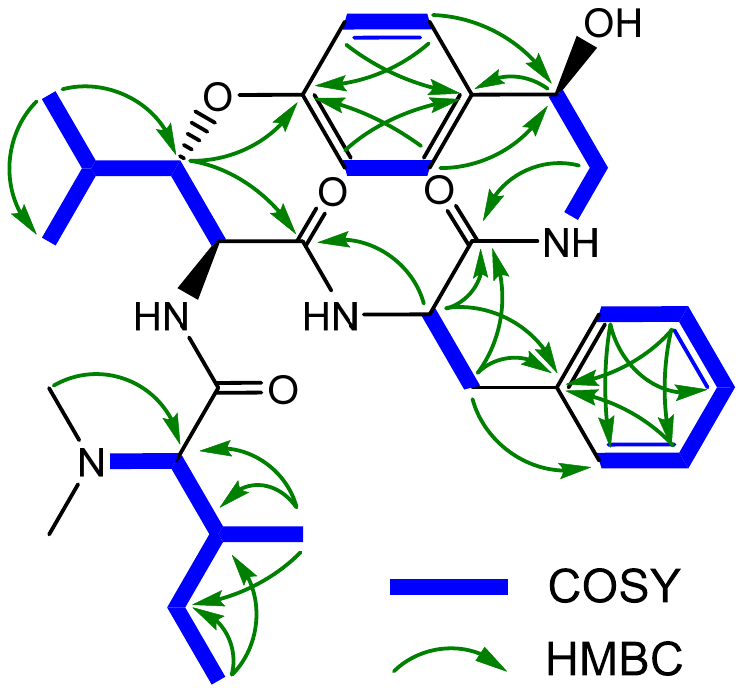
Figure 3. Key 2D NMR correlations of pandamine ( 1 ). Particular attention has been paid to the signals associated with the stereochemically- undefined β -hydroxyleucine residue. The magnitude of the vicinal coupling constants re- lated to the β -methine of the oxyleucine residue H-9 ( δ H 4.69, dd, J = 9.0, 1.8 Hz) were strongly reminiscent of those observed in 14-membered ansapeptides featuring an erythro- β -hydroxyleucine, hinting that pandamine should include a similar relative con- figuration for this residue [34] (a threo configuration would be expected to result in a J 8,9 coupling of about 2 Hz) [35]. Likewise, the cursory analysis of the 13 C NMR chemical shifts related to the α and β -methines for the L -erythro and D -erythro β -OH amino acids incor- porated in 14-membered para ansapeptides disclosed significant differences between them. The presently determined chemical shifts of C-8 and C-9 were indicative of an L - erythro- β -hydroxyleucine residue [35]. These spectroscopic landmarks provided strong spectroscopic support for the commonly depicted configuration of this residue (Figure 2), despite the apparent lack of direct evidence. The cursory analysis of the NMR signals re- lated to the hydroxystyrylamine side chain were strongly reminiscent of those of sanjoinine G1, where the 1 R absolute configuration had been assigned on the basis of the exciton-coupled circular dichroism [36]. The magnitude of the vicinal coupling constants related to the diastereotopic methylenic protons H-2 and the ROE crosspeak between H- 1 and the more unshielded proton of this methylenic pair supported an identical 1 R con- figuration, as seminally determined by Horeau’s method [2].